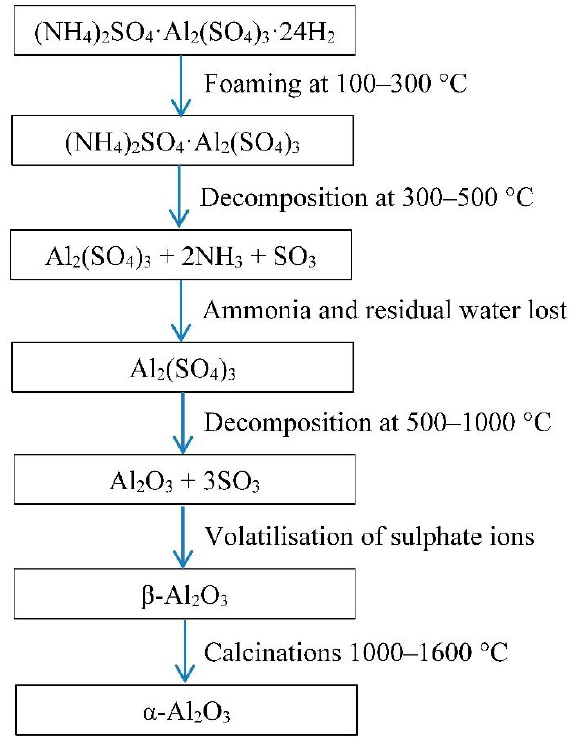
Figure 1. Chemical synthesis of aluminium sulphate and ammonium sulphate